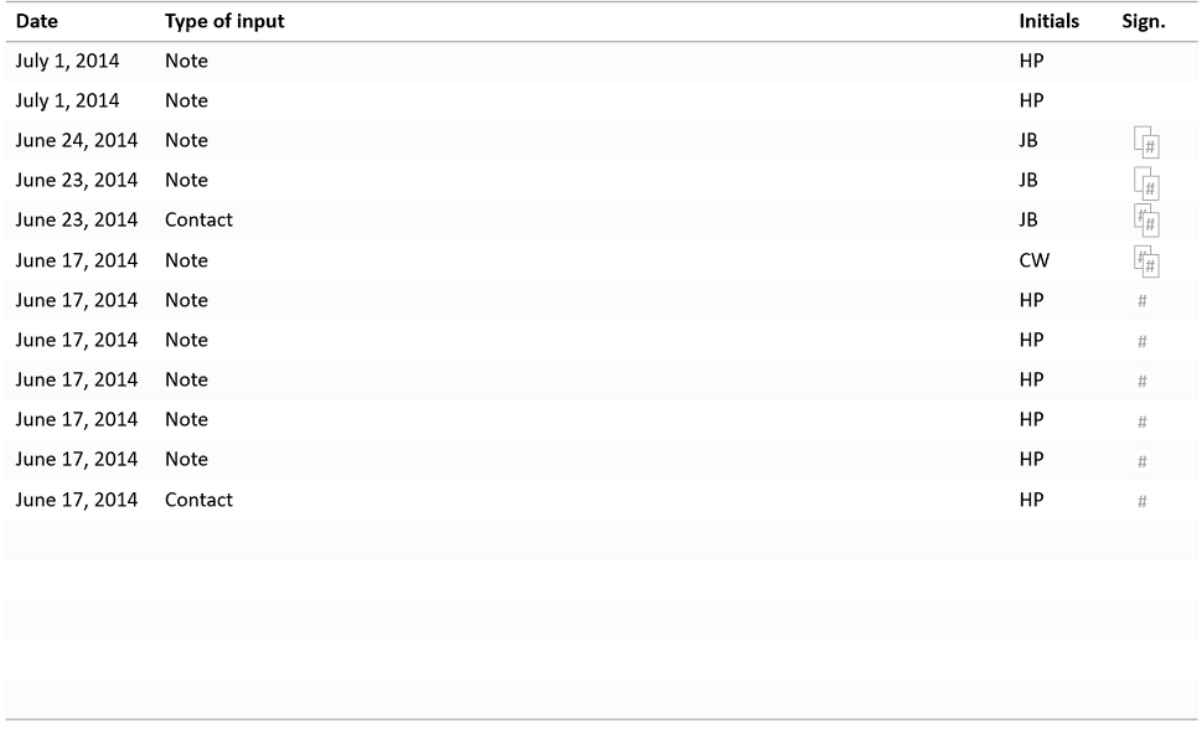
Figure 2. An illustration of how one view of the health record for one patient can look in the system. There is one input line per date, and all inputs here are either notes or information about the patient contact made. The “Initials” column shows who made the input, and the “Sign.” column shows the signing status: an empty space indicates that all signing has been completed; a single hashtag indicates that signing needs to be done; the overlapping hashtags (one or two) indicate that a post was signed but then changed and needs to be looked at and signed again.